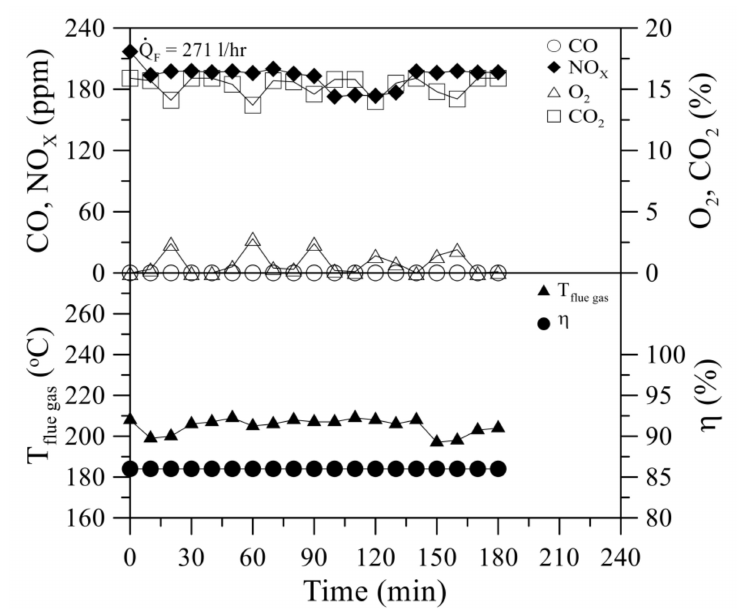
Figure 8. Combustion characteristics when firing pure low-sulfur fuel oil without cleaning the boiler tubes.